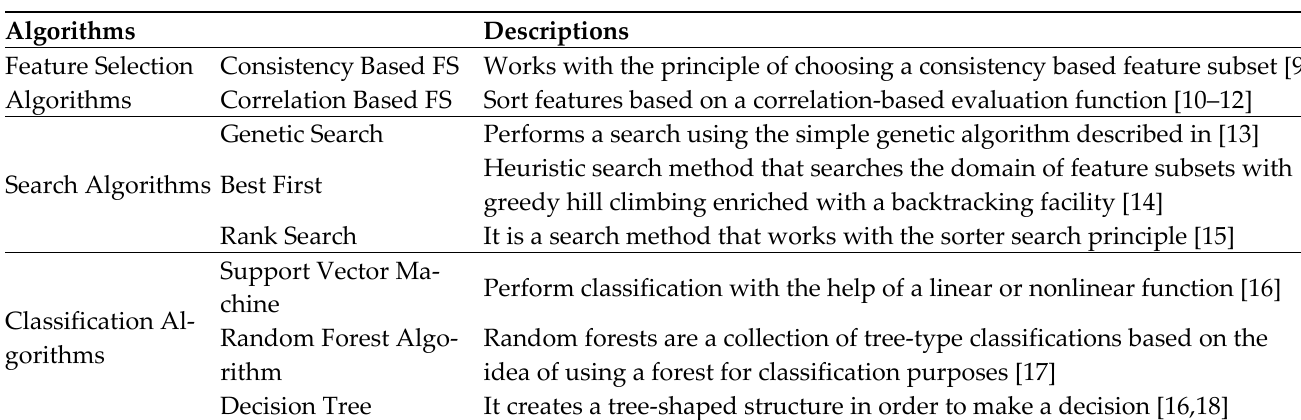
Table 1. Used Algorithms.